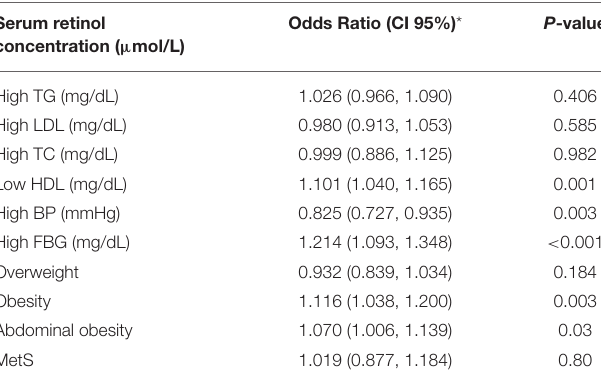
TABLE 5 | Adjusted odds ratio (OR) for the effect of serum retinol levels on the development of obesity and abnormal cardiometabolic factors. Serum retinol Odds Ratio (CI 95%) concentration ( µ mol/L)